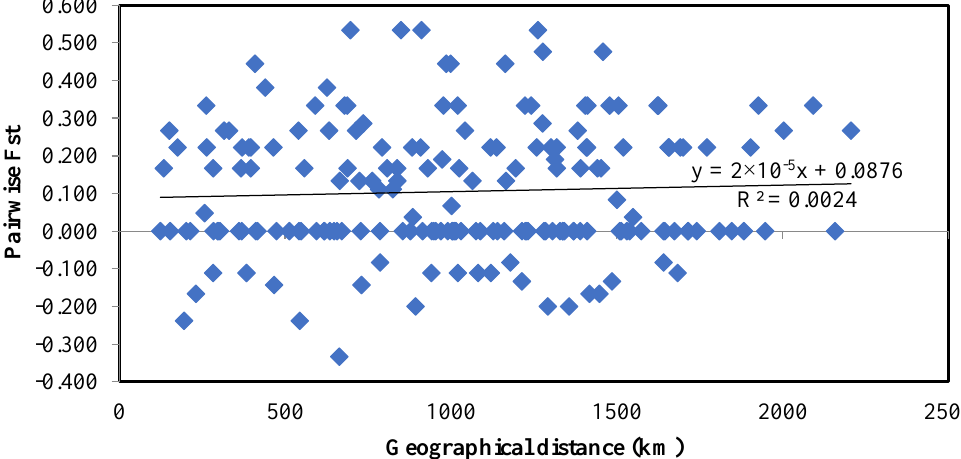
Figure 4. Correlation between pairwise genetic differentiation using COI gene sequences and geo- graphical distance among the different M. vitrata populations sampled across India.